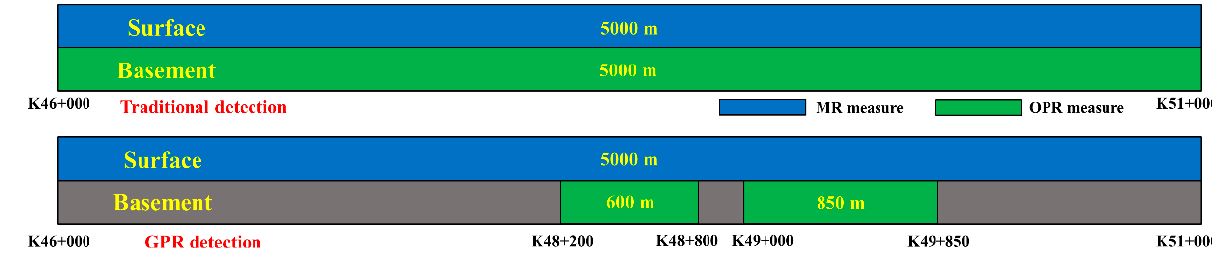
Figure 12. The selection of maintenance schemes based on traditional detection and GPR detection.